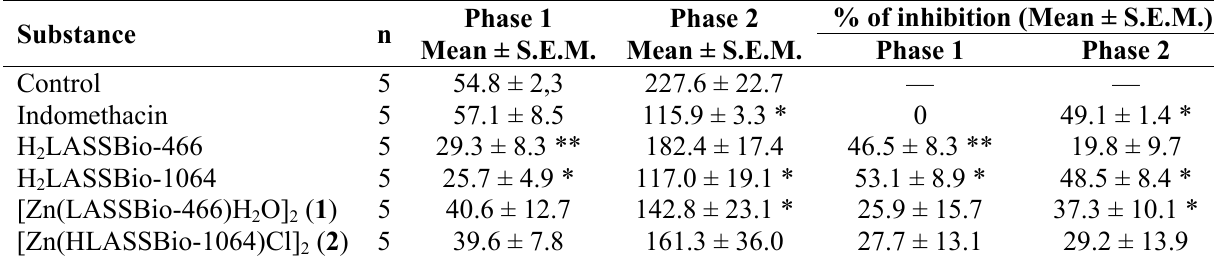
Table 4. Effect of prototypes H